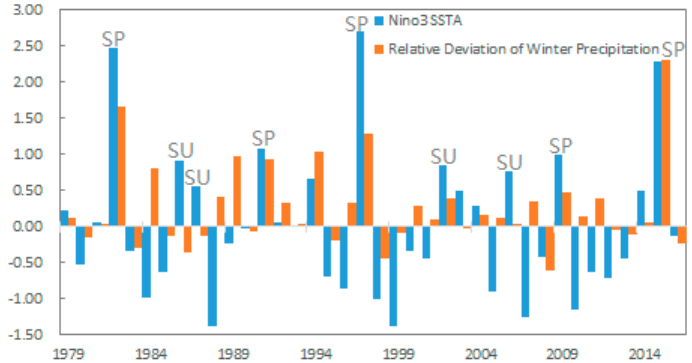
Figure 2. Averaged ( a ) monthly precipitation (units: mm·month − 1 ; contour interval: 20 mm·month − 1 ; shaded areas indicate precipitation above 40 mm·month − 1 ) and ( b ) winter precipitation percentage (units: %; contour interval: 4%; shaded areas indicate precipitation percentages above 8%) during DJF 1979–2016. The red rectangle denotes the location of South China (22° N–30° N, 108° E–120° E).